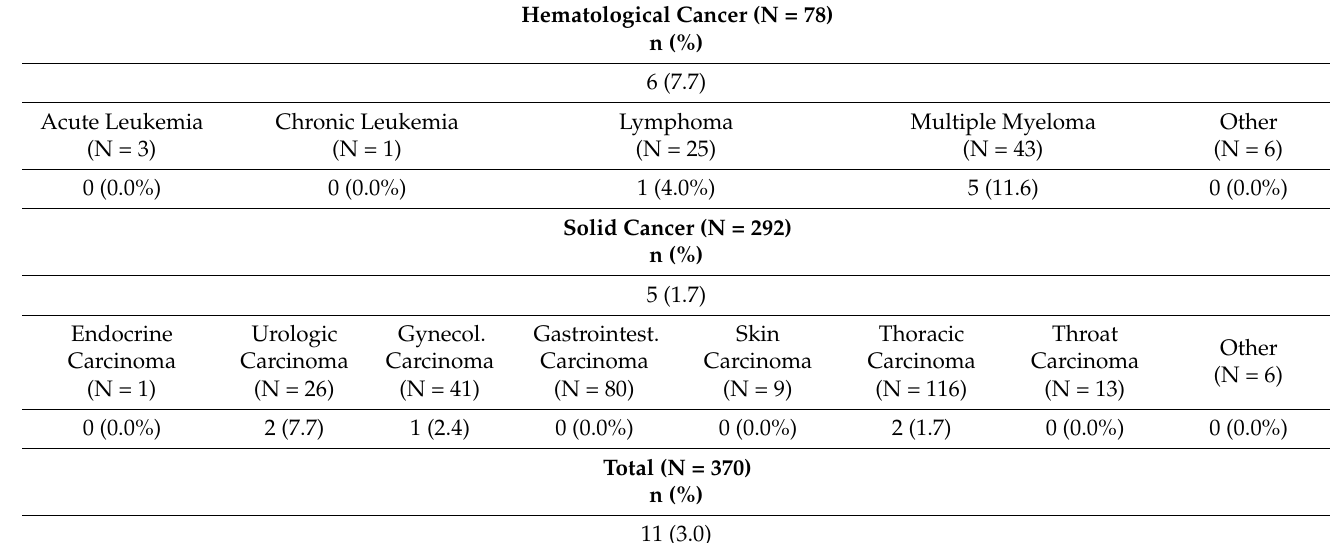
Table 1. Shingrix ® vaccination rates according to underlying cancer disease in frequency (n) and percentage (%).